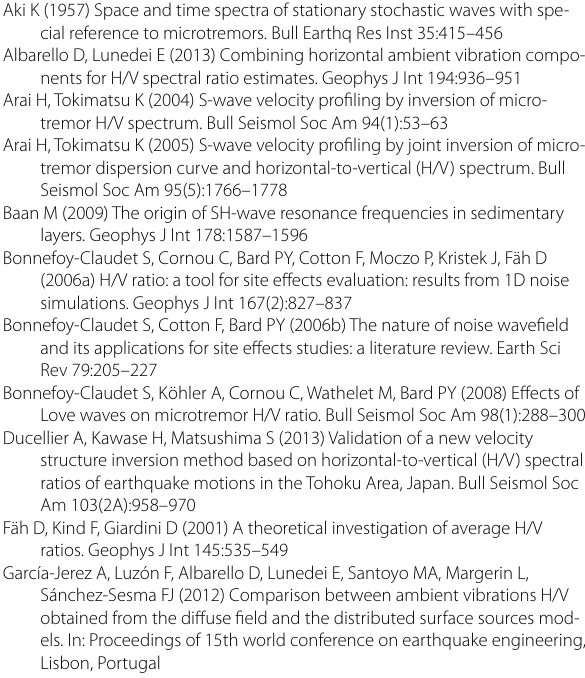
Table S3 . Underground velocity structure model at GIFH28. Table S4 . Underground velocity structure model at GIFH29. Table S5 . Underground velocity structure model at SZOH26. Table S6 . Underground velocity structure model at KMMH14. Additional file 2: Table S1. Small events at TCGH16. Table S2 . Small events at KMMH03. Table S3 . Small events at GIFH28. Table S4 . Small events at GIFH29. Table S5 . Small events at SZOH26. Table S6 . Small events at